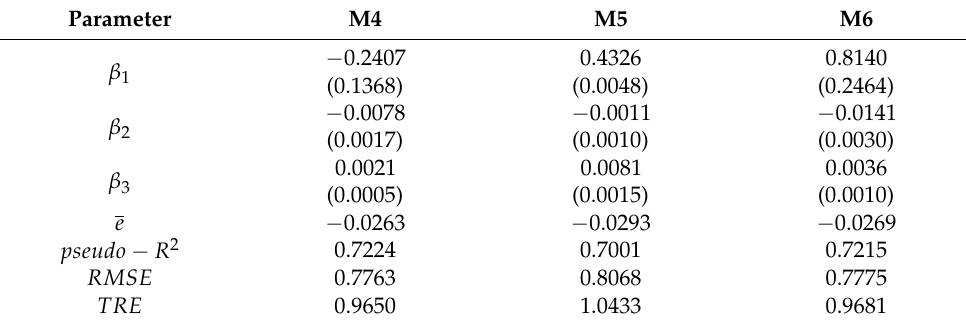
Table 5. Parameter estimates and fit statistics of the three basic